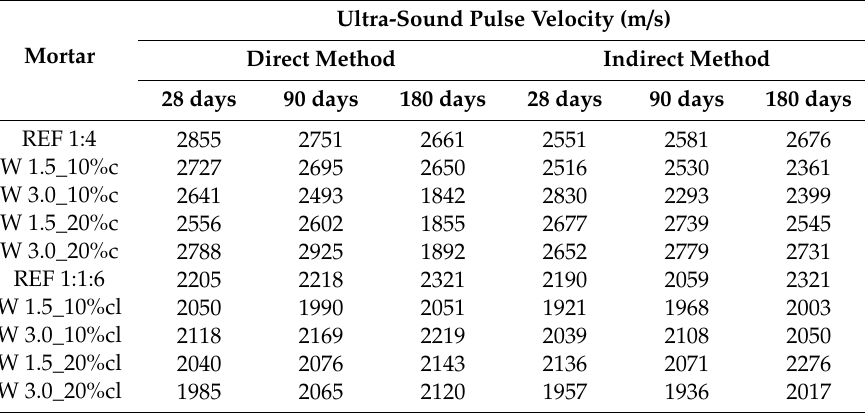
Table 5. Ultra-sound pulse velocity of the mortars tested.